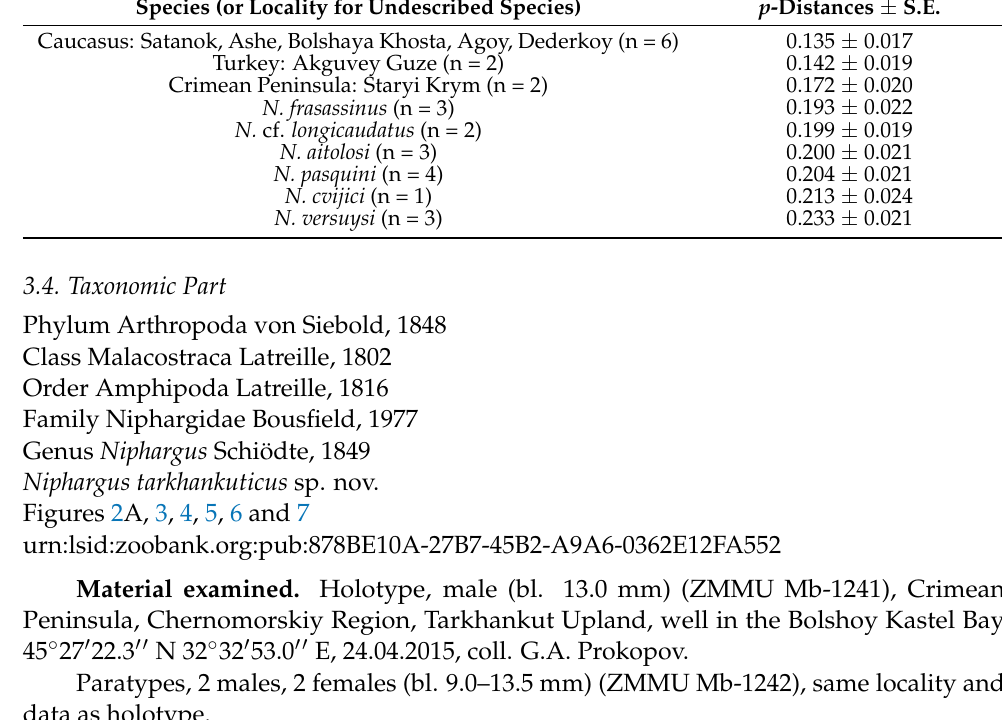
Table 2. Uncorrected pairwise genetic (COI mtDNA) distances ( p -distances) (substitutions per 100 nucleotides) ( ± S.E.) between Niphargus tarkhankuticus sp. nov. and other relative congeners. Species (or Locality for Undescribed Species) p -Distances ± S.E. Caucasus: Satanok, Ashe, Bolshaya Khosta, Agoy, Dederkoy (n = 6) 0.135 ± 0.017 Turkey: Akguvey Guze (n =